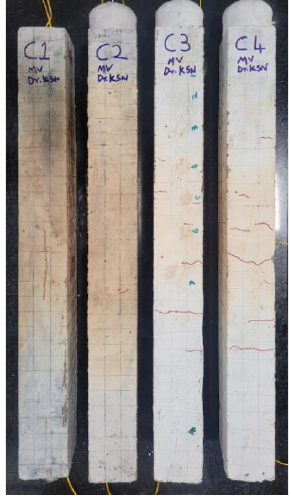
Figure 22. Postfire images of the specimens.